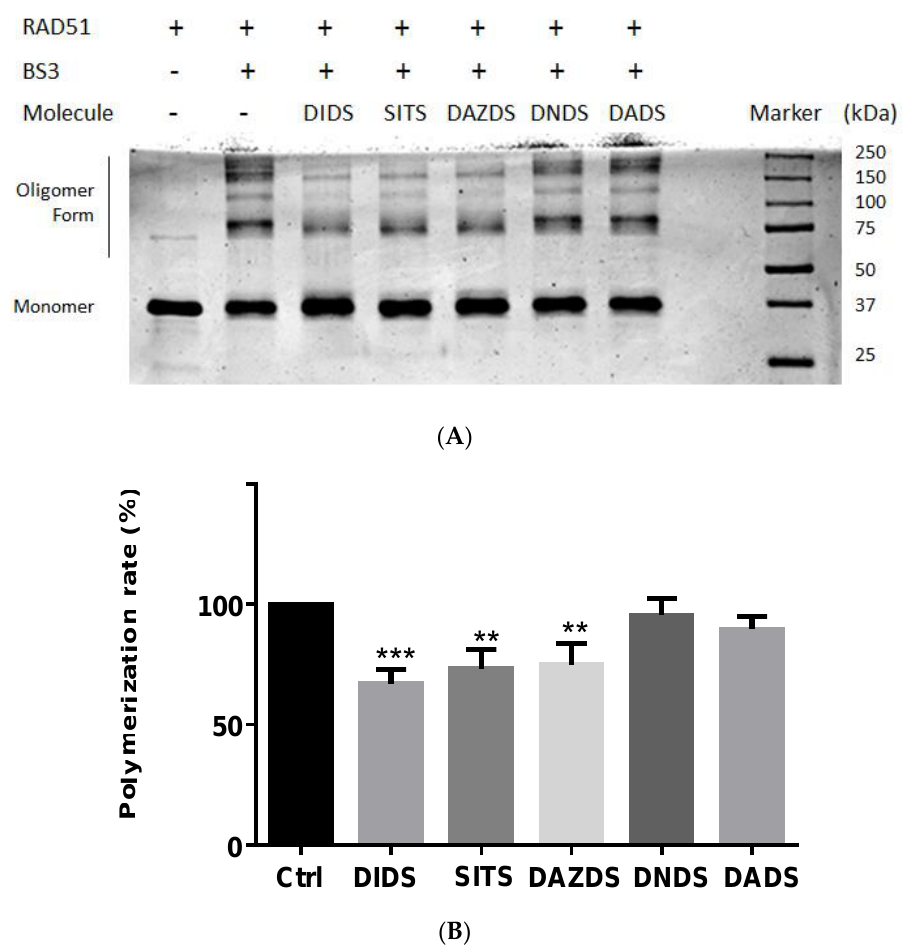
Figure 4. Self-association of RAD51 is inhibited in the presence of DIDS, SITS, and DAZDS. ( A ) The polymerization of RAD51 was estimated by cross-link approach (see Material and Method section). ( B ) Oligomer and monomer forms ratio is presented as a histogram graph. Three independent experiments were performed and statistical analysis was performed using paired Student’s t -test. Statistical significance was assumed at ** p < 0.01, *** p < 0.001. Each error bar represents s.d. statistical analysis.